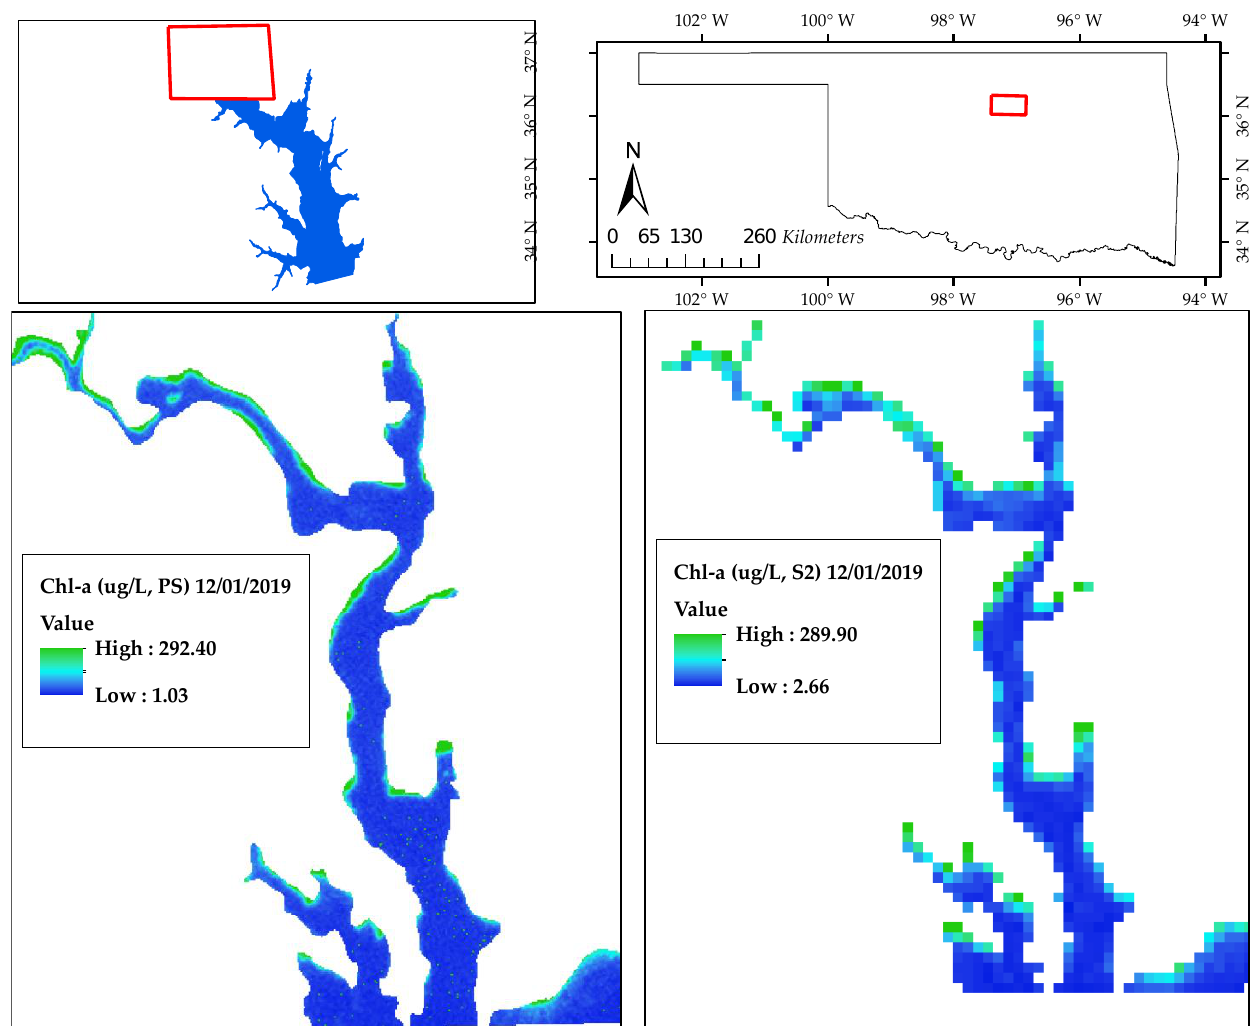
Figure 8. PS ( Left ) and Sentinel-2 ( Right ) maps of Chl-a in Lake McMurtry, northcentral Oklahoma. Both satellites acquired their images on 1 December 2019, during an active algal bloom event. The overview maps at the top show the location of Lake McMurtry in Oklahoma (Top right spec in a red box) and Lake McMurtry (Top left) showing the focus area delineated by a red box. The color bars represent concentration ranges as estimated by each of the two satellites.